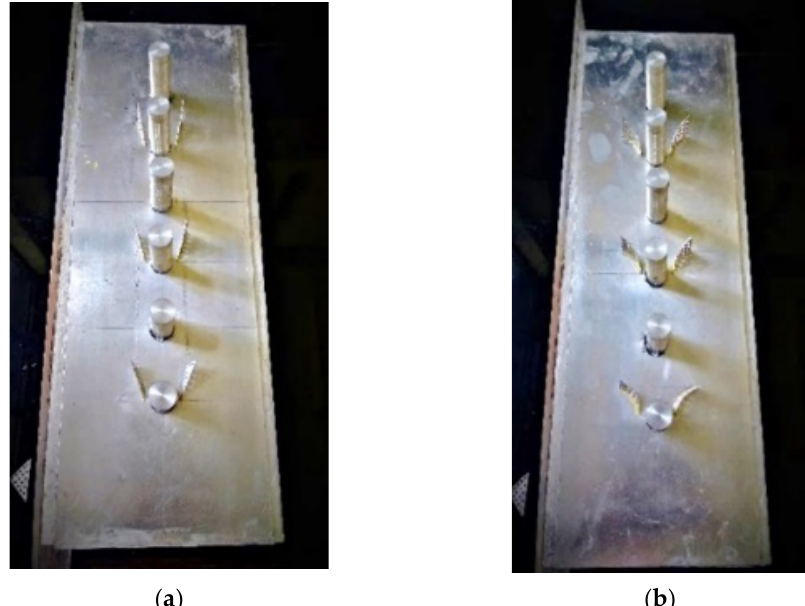
Figure 3. Test specimen: ( a ) three pairs of PDW VGs and ( b ) three pairs of PCDW VGs.